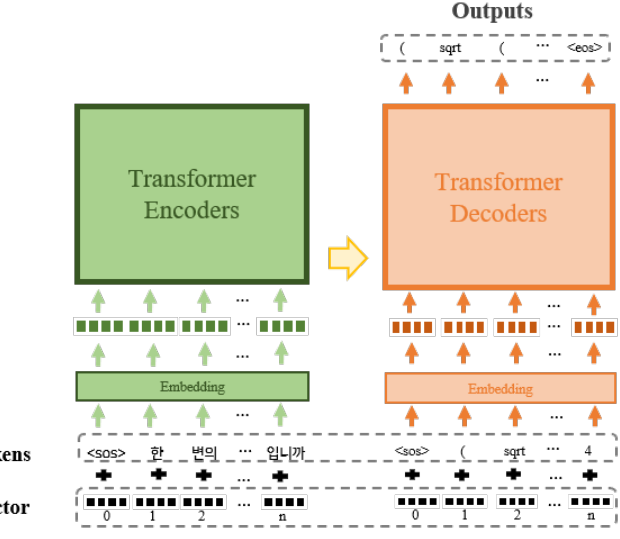
Figure 3. Structure of the Transformer model. The encoder of the Transformer delivers the seman- tic information of the input sentence obtained through self-attention and multi-head attention to the decoder.